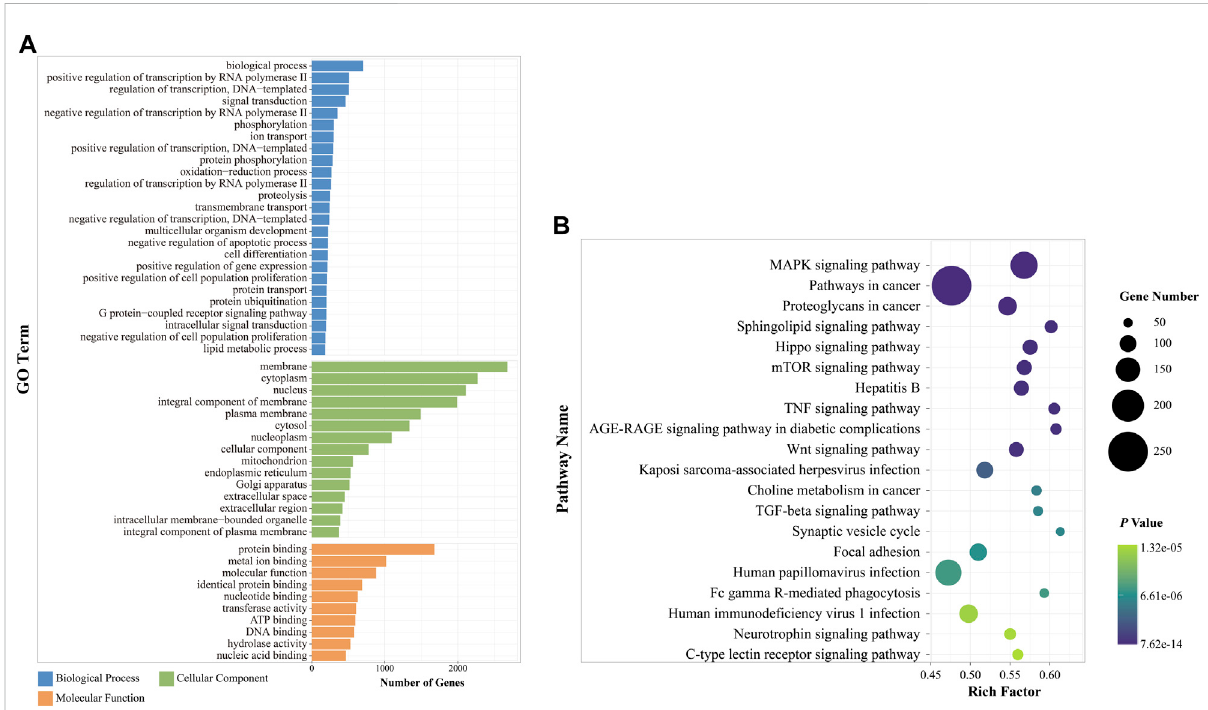
FIGURE 5 FunctionalenrichmentanalysisofDEmiRNAsbetweentheACUandDORgroups. (A) GOannotationofDEmiRNAsafteracupuncture( p < 0.01). The x -axis indicated the number of miRNAs in each term, and the y -axis on the left indicated the enriched GO term. Different colors represented differentGOterms. (B) KEGGenrichmentofDEmiRNAsafteracupuncture.Thetop20termsaredisplayed( p < 0.01).Thesizeofeachdotisbasedon the enrichment of DE miRNAs. GO, Gene Ontology; KEGG, Kyoto Encyclopedia of Genes and Genomes. ACU, acupuncture group; CON, control group; DOR, diminished ovarian reserve; DE miRNAs, differentially expressed